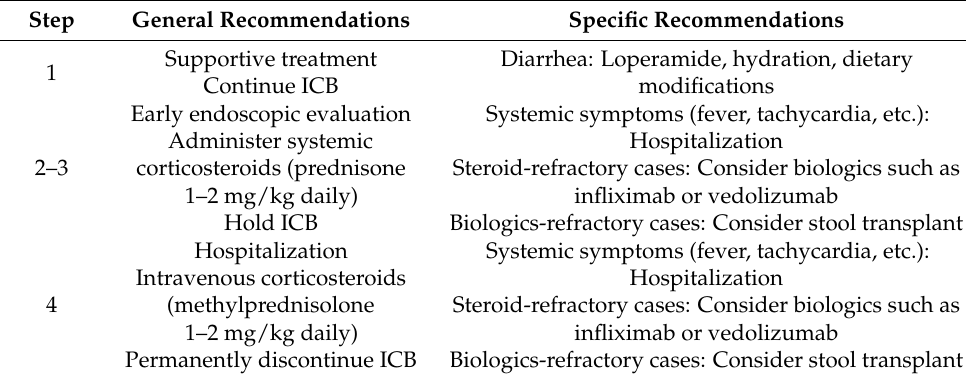
Table 5. Management recommendations for